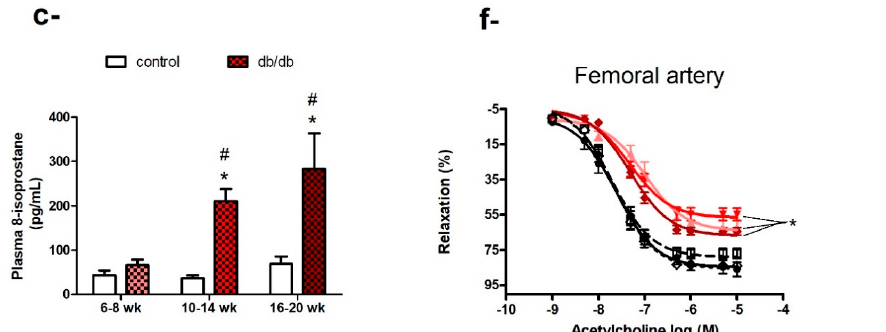
Figure 1. Age ‐ related changes in diabetic status and endothelial dysfunction in db/db mice. Plasma glucose ( a ) and insulin ( b ) levels following an intraperitoneal injection of glucose in db/db and control mice at six, 10, or 16 weeks of age ( n = 6–10; areas under the curve (AUCs) were compared by two ‐ way ANOVA followed by Bonferroni post ‐ test). ( c ) Histogram of plasma 8 ‐ isoprostane levels in db/db and control mice at six, 10, or 16 weeks of age ( n = 5–10; two ‐ way ANOVA followed by Bonferroni post ‐ test). Cumulative concentration–response curves of acetylcholine in the aortae ( d ), carotid arteries ( e ), and femoral arteries ( f ) of db/db and control mice at 6–8 weeks, 10–14 weeks, and 16–20 weeks of age ( n = 6–10 mice; two ‐ way repeated ‐ measures ANOVA followed by Bonferroni post ‐ test). Results are expressed as mean ± standard error (SE). * denotes p < 0.05 vs. age ‐ matched control, # denotes p < 0.05 vs. db/db (6–8 weeks), @ denotes p < 0.05 vs. db/db (10–14 weeks).